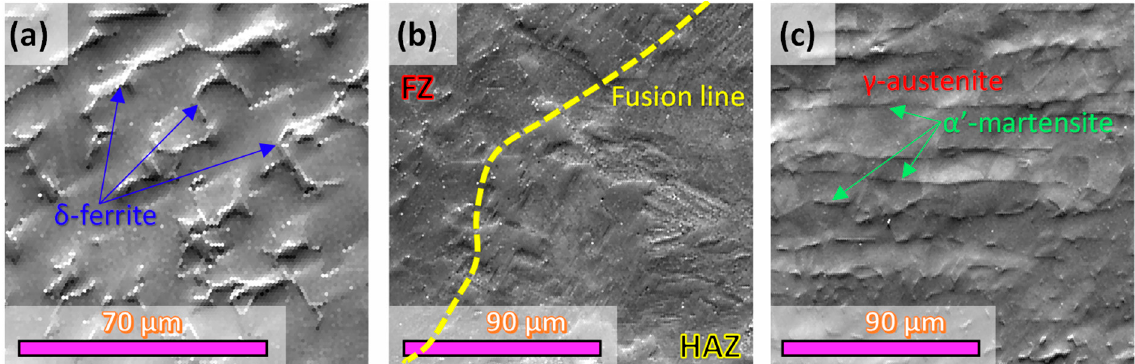
Figure 4. SEM images for all the analyzed zones. ( a ) FZ, ( b ) fusion line defining the border between the FZ and the HAZ, and ( c ) BM.